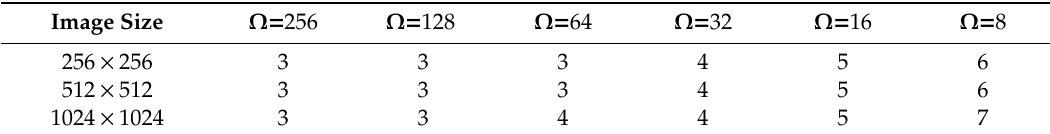
Table 1. Values of f according to image size and Ω